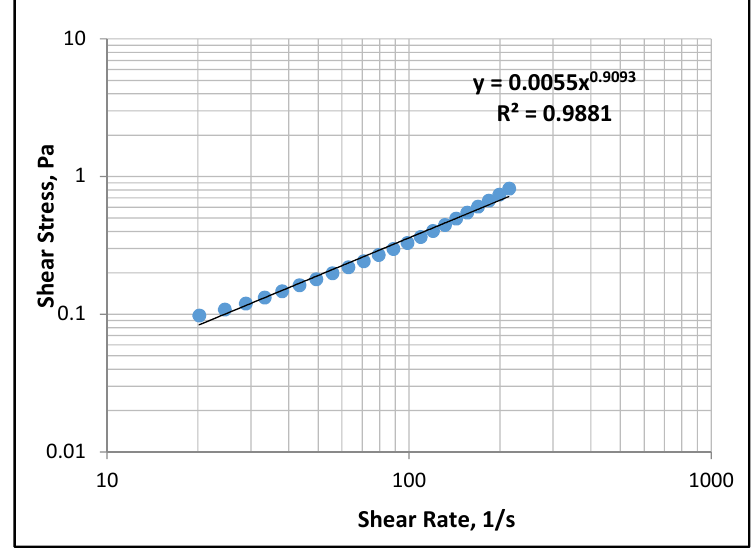
Figure 1. Rheogram of the polymer fluid used in the study.